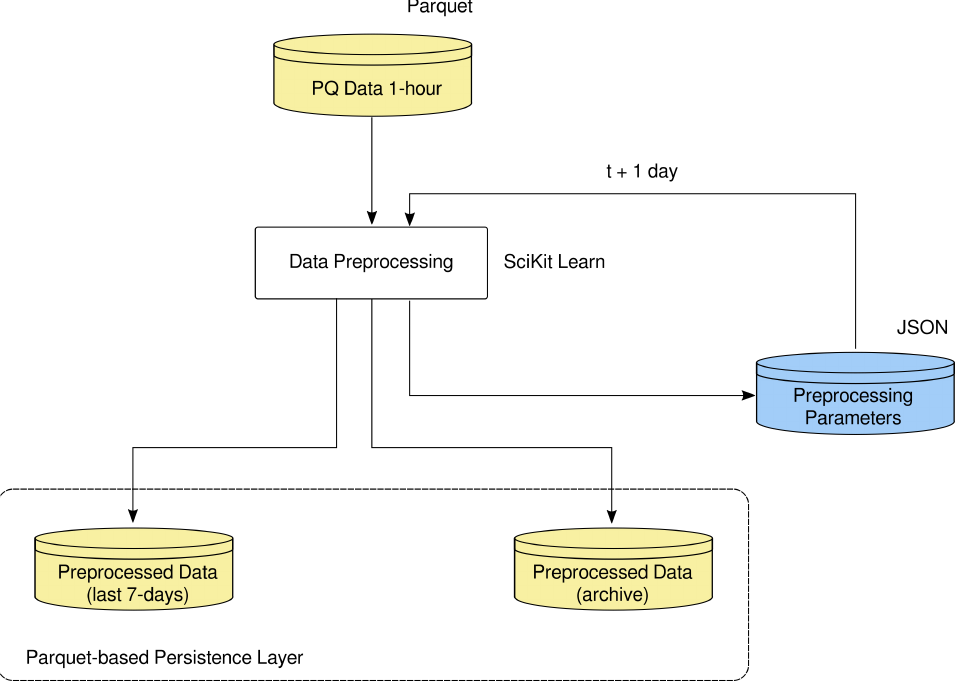
Figure 4. Data-preprocessing component of MIRD. Eight-variable time series at 1-h resolution are preprocessed based on the parameters in the JSON archive. Preprocessed time series are passed as input to the forecasting component and archived to the Parquet-based persistence